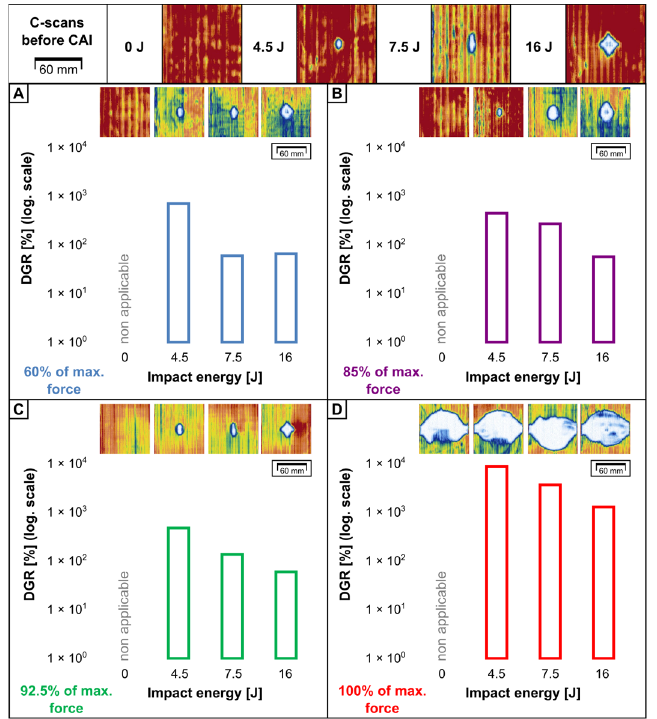
Figure 11. Ultrasonic C-scans of damaged areas in ACL laminates before CAI and after CAI for following force thresholds: 60% ( A ), 85% ( B ), 92.5% ( C ) and maximal force ( D ). Also the relation of delamination growth ratio to impact energy was presented.